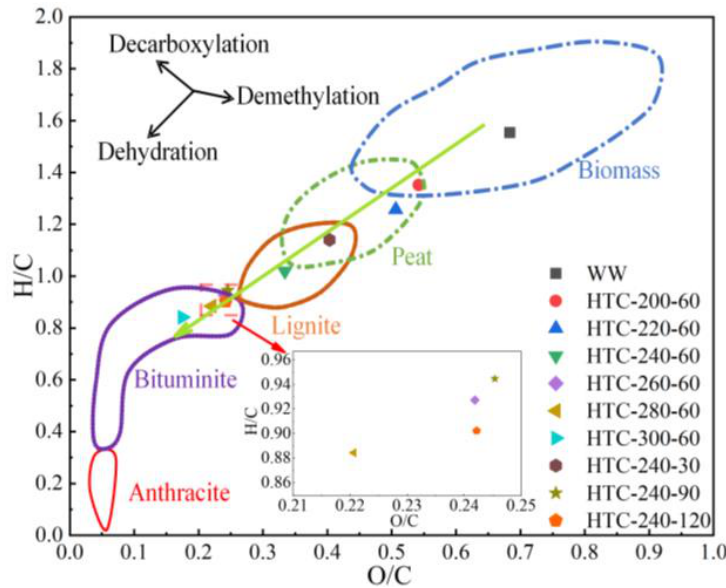
Figure 4. Van Krevelen diagram of WW and different hydrochar.